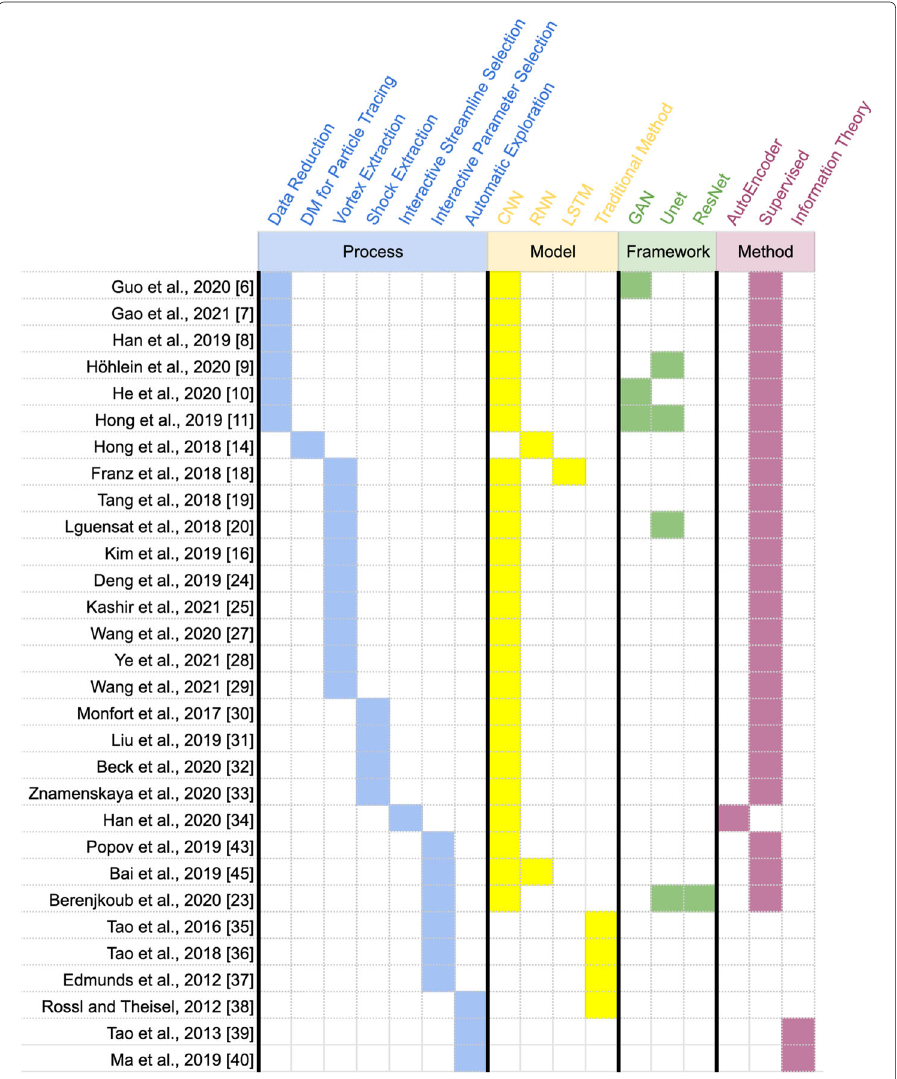
Fig. 2 The table organized the deep learning approaches for flow visualization by the tasks, model type, model architecture, and training